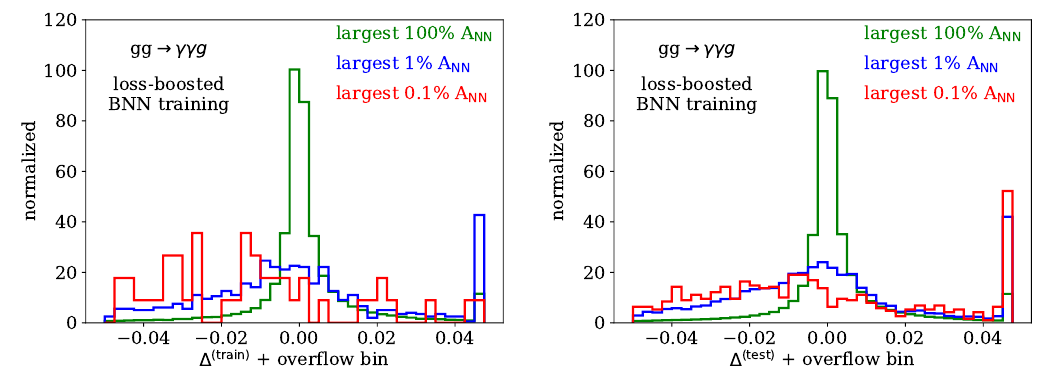
Figure 7: Performance of the loss-boosted BNN in terms of the precision of the gener- ated amplitudes, Eq.(3), evaluated on the training and test datasets on a linear (left) and logarithmic (right) axis. The curves can be compared to the BNN results without boosting in Fig. 2.